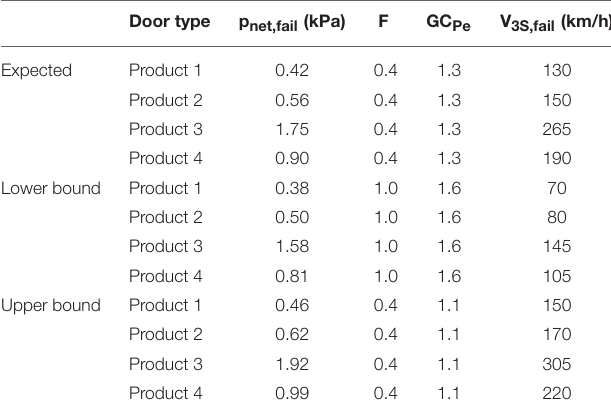
TABLE 5 | Expected, lower-bound, and upper-bound failure wind speeds of garage